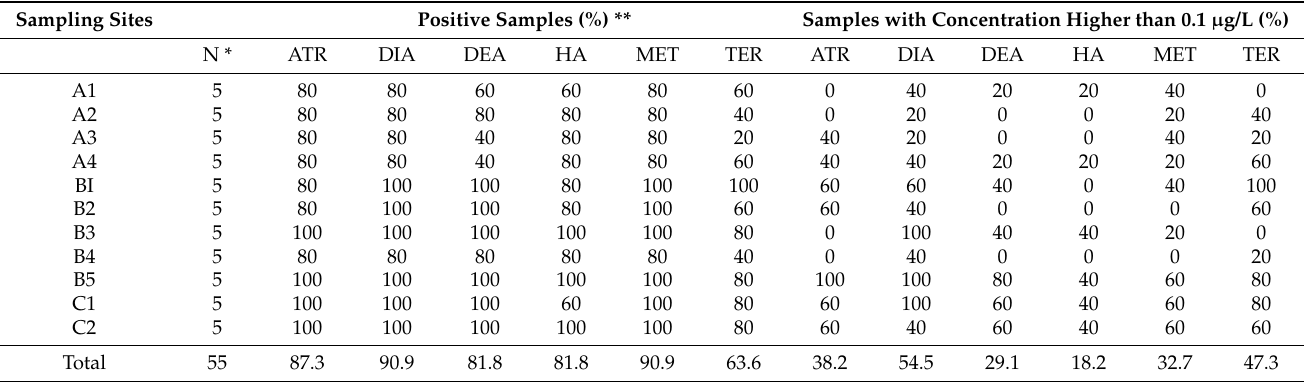
Table 3. Summary of positive samples in pesticide residues and exceedances of the EU permissible limit.